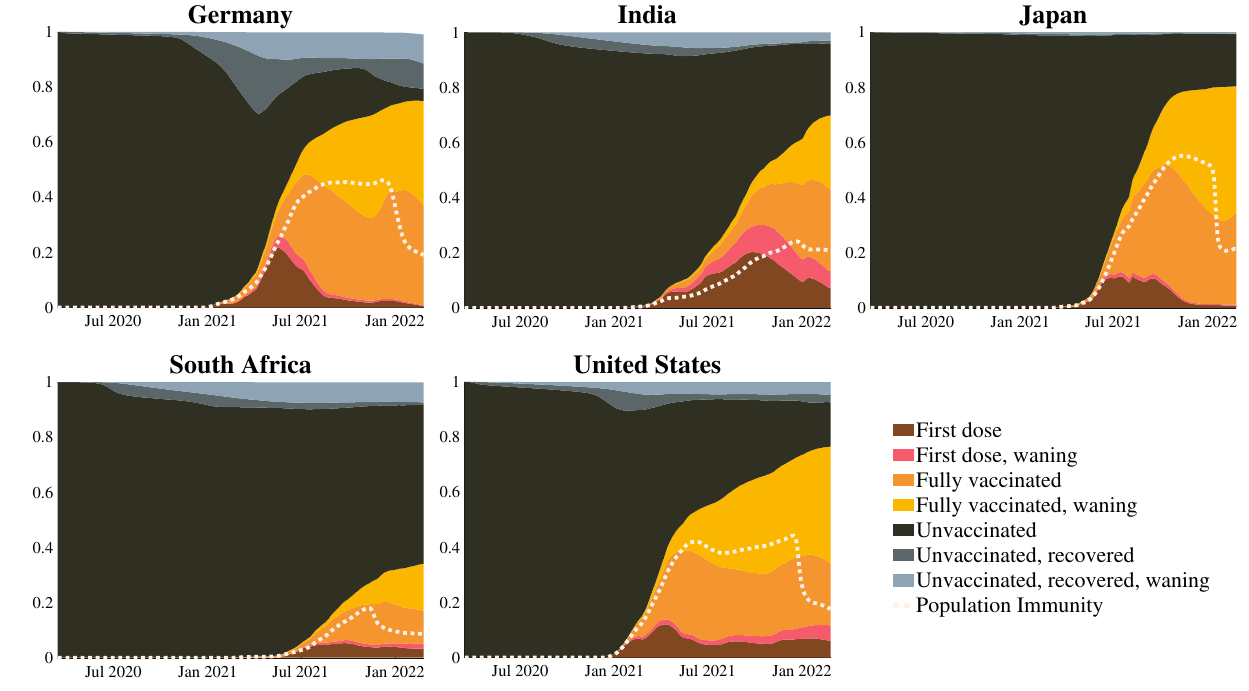
Figure 3. Proportions of various immunity levels in five countries modeled over time. Overlain in the white, dotted line measures population immunity, weighted proportionally to all population groups and prevalent variants. A value of zero represents no population immunity, and a value of one represents complete population immunity and no susceptibility to future